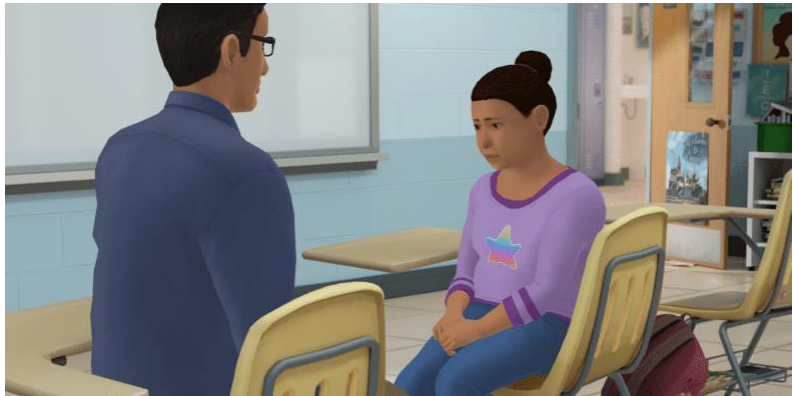
Figure 1. Screenshot from Resilient Together: Coping with Loss at School